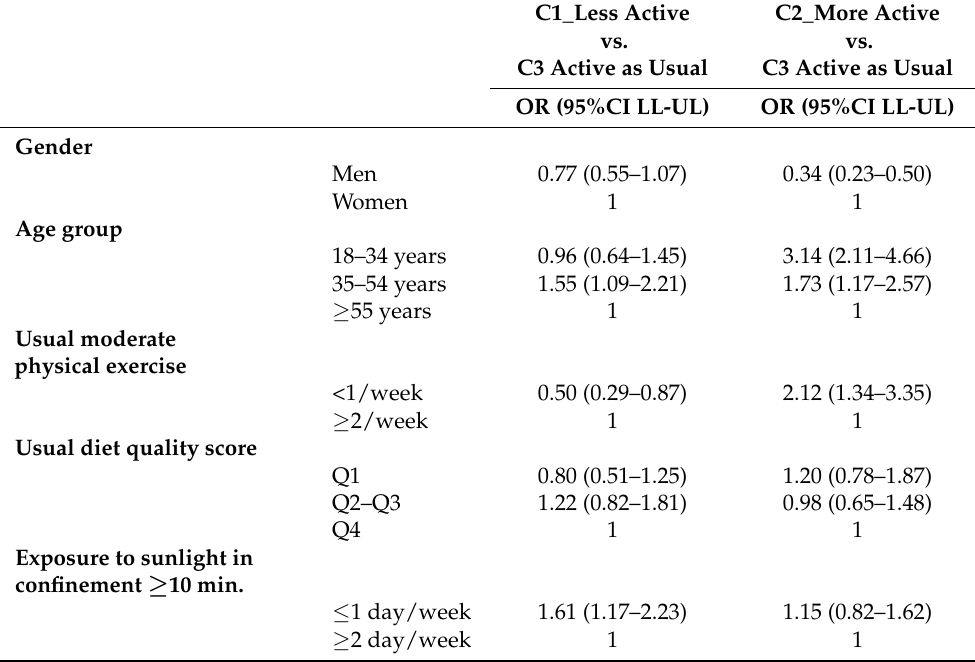
Table 2. Association between cluster of change in physical activity and dietary habits during lockdown, sociodemographic factors, and usual